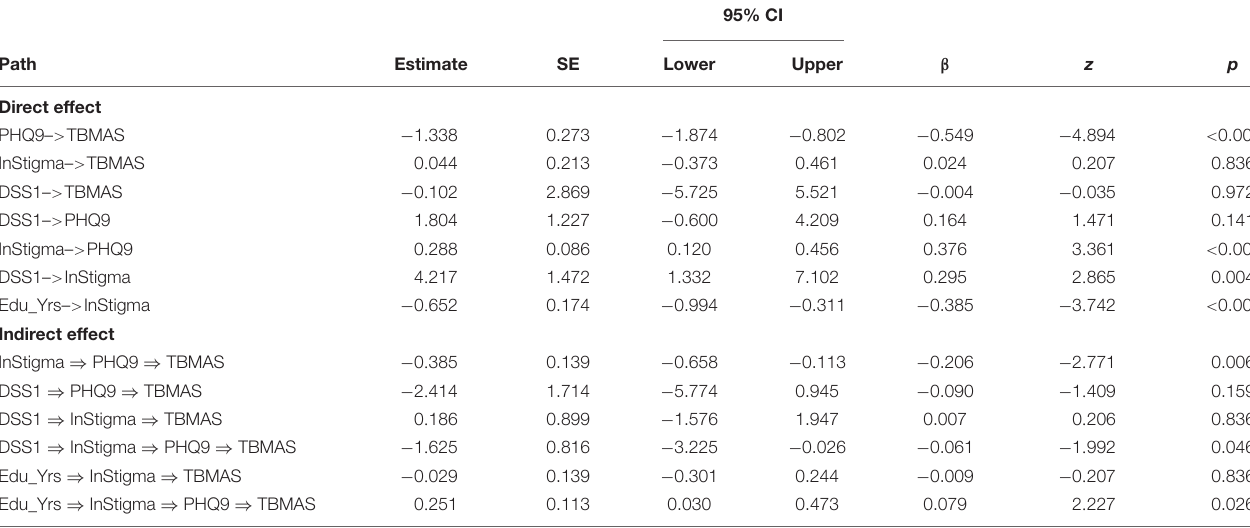
TABLE 3 | Direct and indirect path